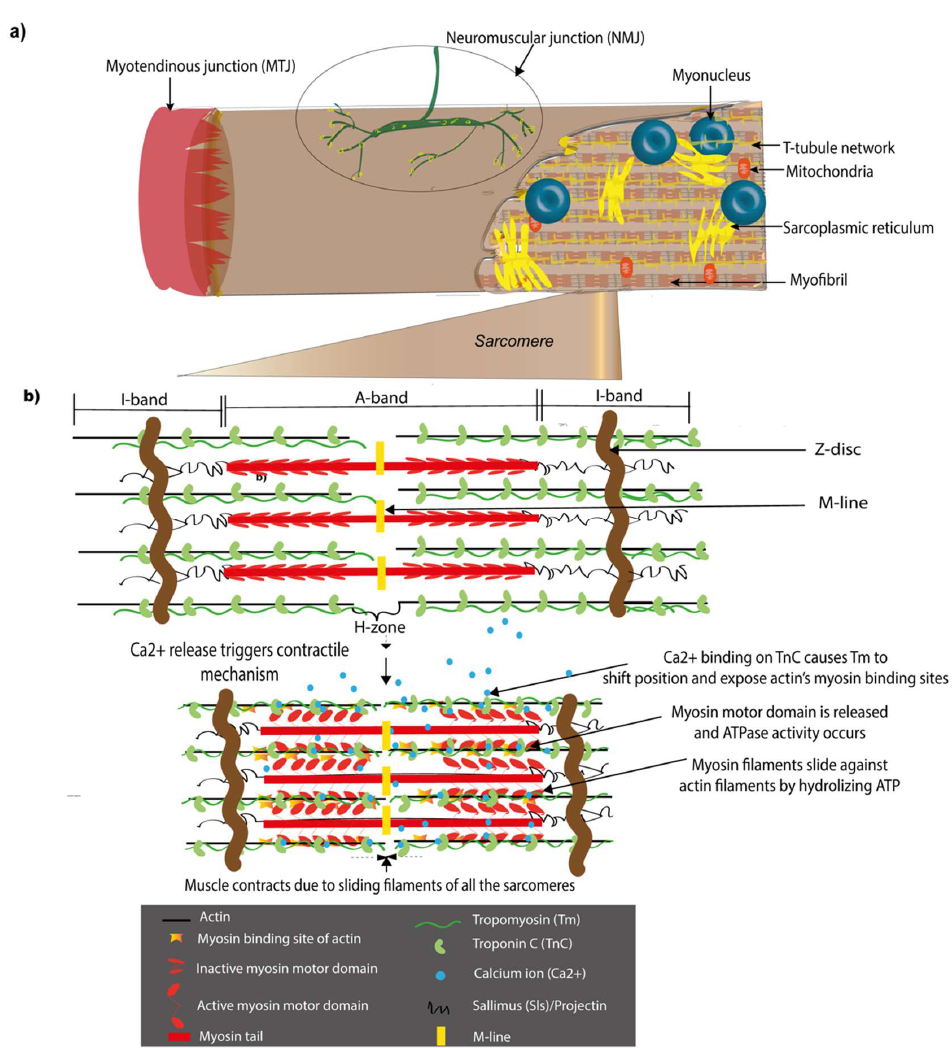
Figure 1. Schematic representation of the larval body wall or somatic muscle structure and the sliding filament theory of muscle contraction. ( a ) Muscle structure with myofibrils and the network of myonuclei, sarcoplasmic reticulum (SR), T-tubules, and mitochondria. The muscle is connected to the nervous system via the neuromuscular junction (NMJ) and to the epidermis via the myotendinous junction (MTJ). Myofibrils are formed of repetitive contractile units, the sarcomeres. ( b ) The structure of a sarcomere and the mechanism of contraction proposed by the sliding filament theory. Ca 2+ ions released upon neurotransmitter signaling from the NMJ launch a cascade by binding to TroponinC (TnC) on the thin filaments of sarcomeres. This Ca 2+ binding causes a conformation change in Tropomyosin (Tm) bound to actin, exposing actin’s myosin binding sites. This permits the activated myosin motor domain to bind to actin and slide against it by utilizing the energy stored in Adenosine Triphosphate (ATP).